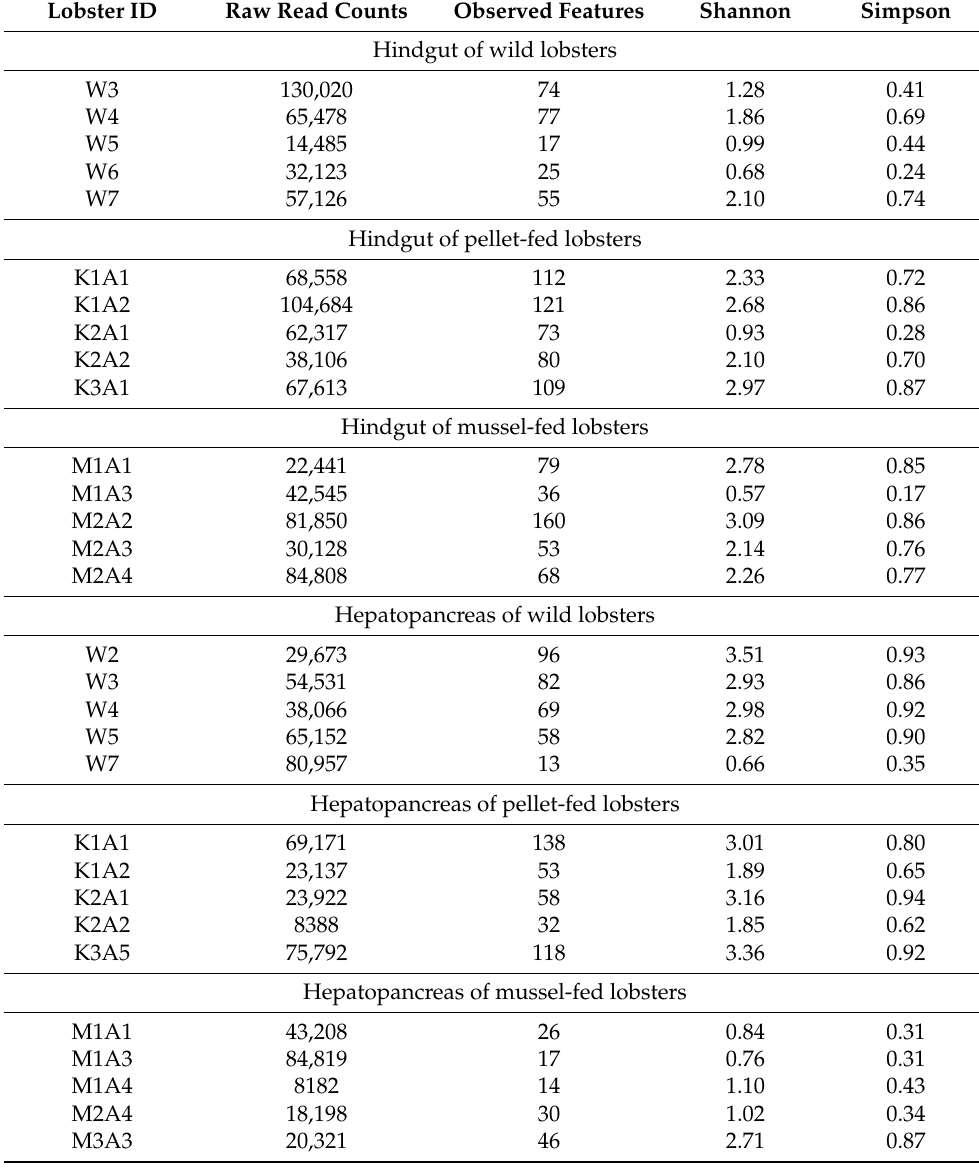
Table 1. Alpha diversity indices for normalised gut libraries of juvenile P. ornatus . Lobster ID Raw Read Counts Observed Features